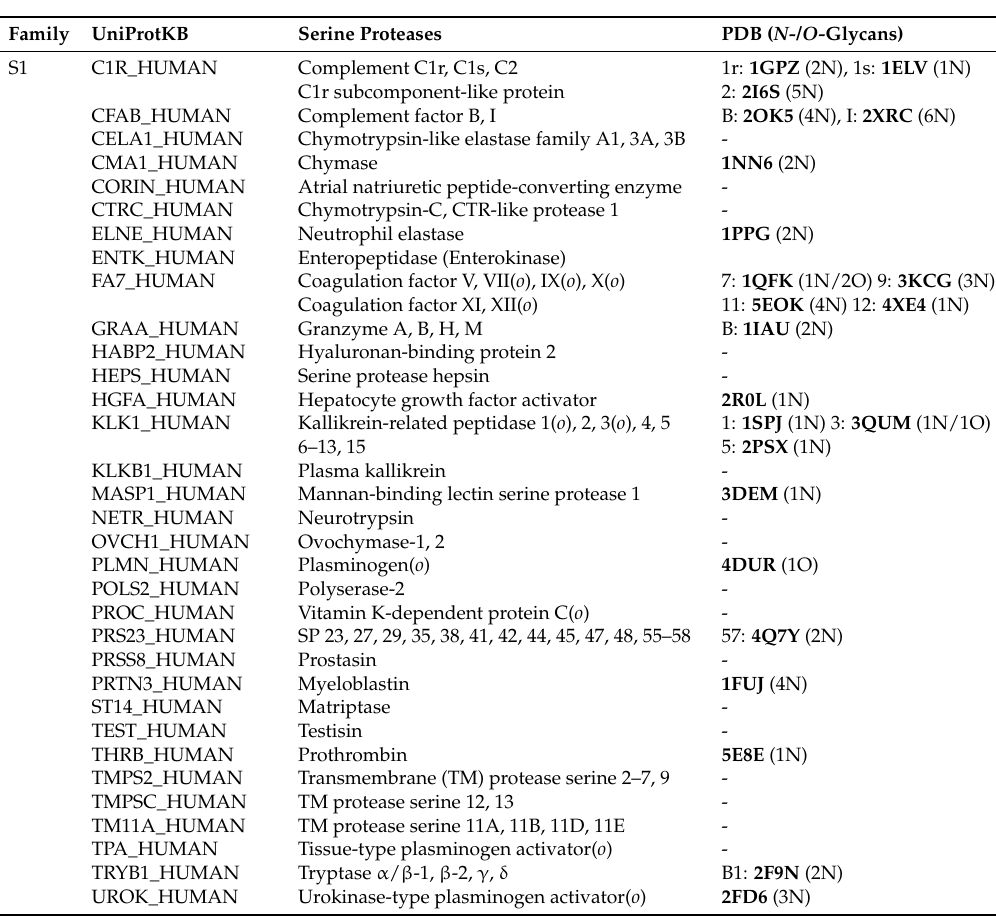
Table 3. Glycosylated human serine protease family S1 (clan PA) members ( o : O -glycans). UniProtKB entries refer to the first example, following ones continue numerical or alphabetical. Selected structures are shown with PDB code in bold and numbers of N - or O -glycosylation sites per monomer. SP: serine